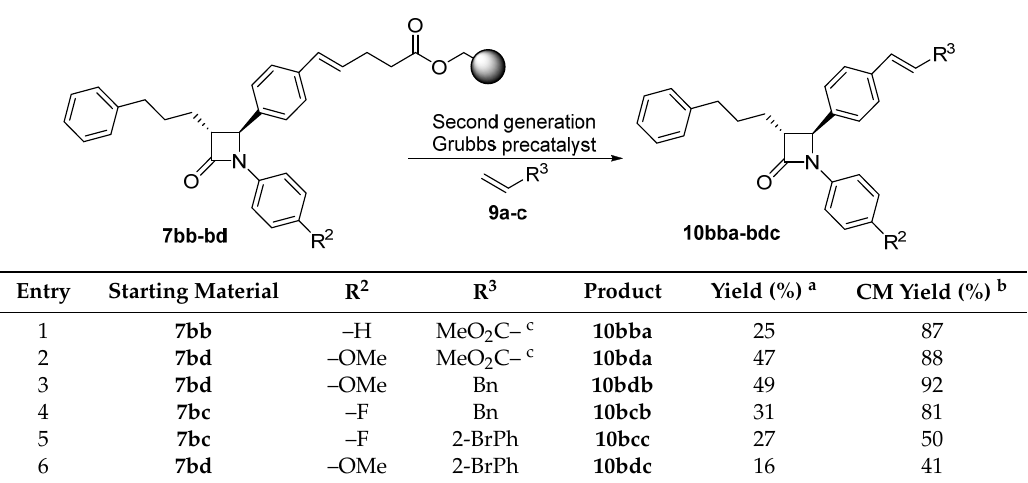
Figure 5. Yields of R 1 and R 2 β -lactam substituents. Table 2. The secondary “Ru1” library of β -lactams.